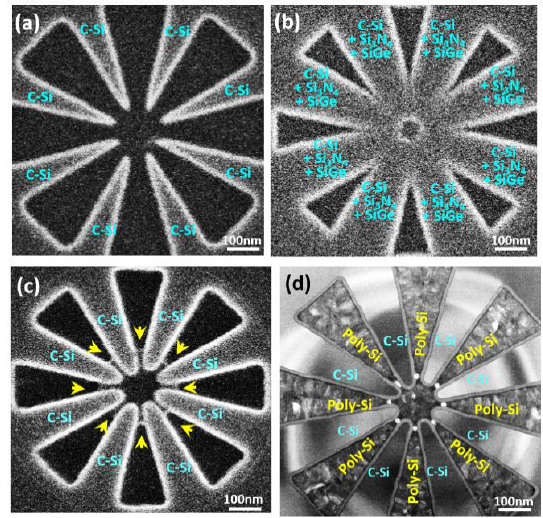
Figure 3. Plan-view SEM/TEM micrographs showing key process steps for the fabrication of closely- coupled Ge octuple QDs located at the included-angle locations of c-Si ridges with specially designed, asterisk-shaped fanout structures. SEM/TEM observations of ( a ) Lithographically patterned c-Si fanout ridges formed on top of SOI substrates. ( b ) Sequential deposition of Si 3 N 4 and poly-Si 0.85 Ge 0.15 layers conformally encapsulating the c-Si ridges. ( c ) Symmetrical spacer layers of poly-Si 0.85 Ge 0.15 fabricated at each sidewall of the Si 3 N 4/ poly-Si ridges by a direct etch back process using SF 6 /C 4 F 8 plasma. Poly-Si 0.85 Ge 0.15 spacer islands (highlighted by yellow arrows) were produced at the central regions by using lithographic-patterning and plasma-etching processes. ( d ) Formation of closely-coupled Ge QDs with diameter of 15 nm at each included-angle location of the c-Si fanout ridges following thermal oxidation. Poly-Si layers were then deposited forming plunger gates and barrier gates.